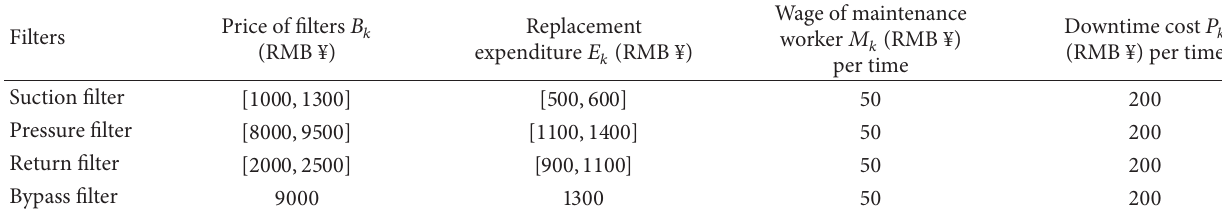
Table 4: Cost data.